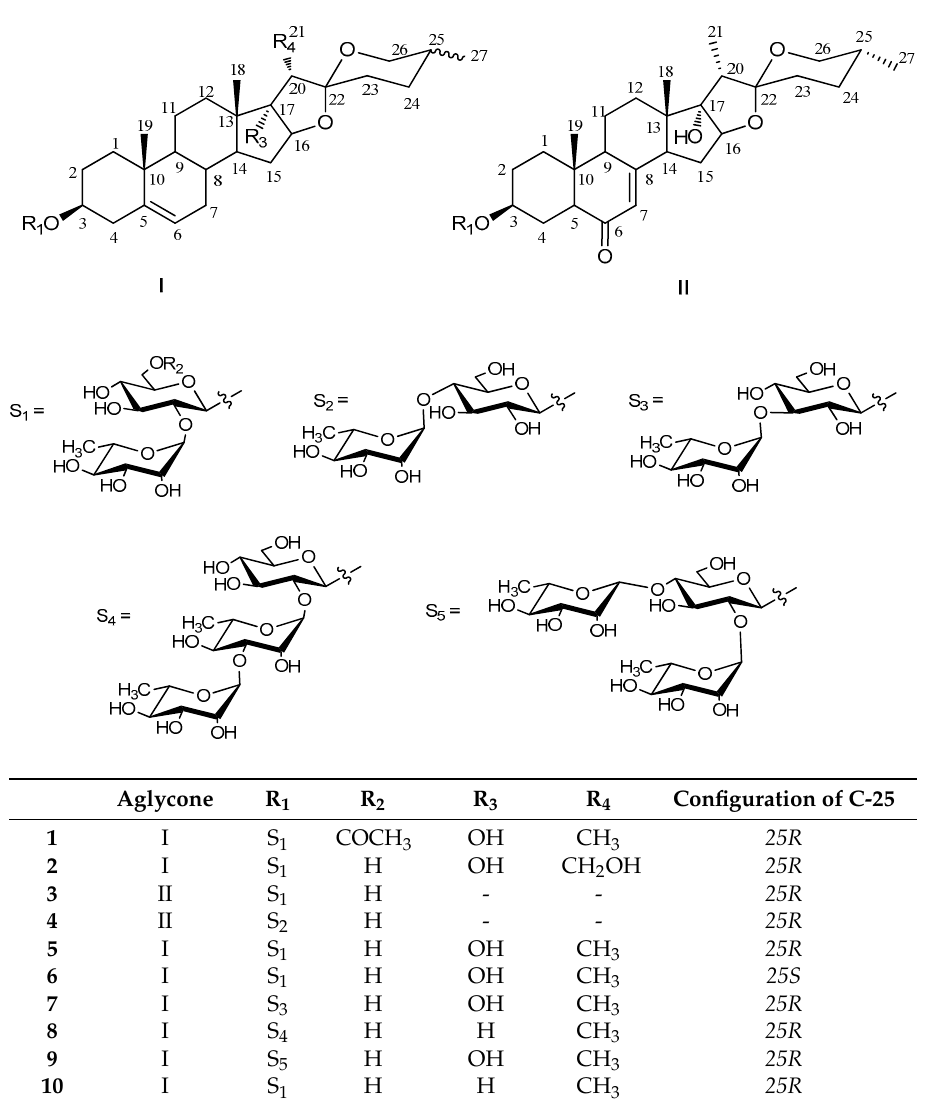
Figure 1. Structures of Compounds 1–10 from Paris vietnamensis .